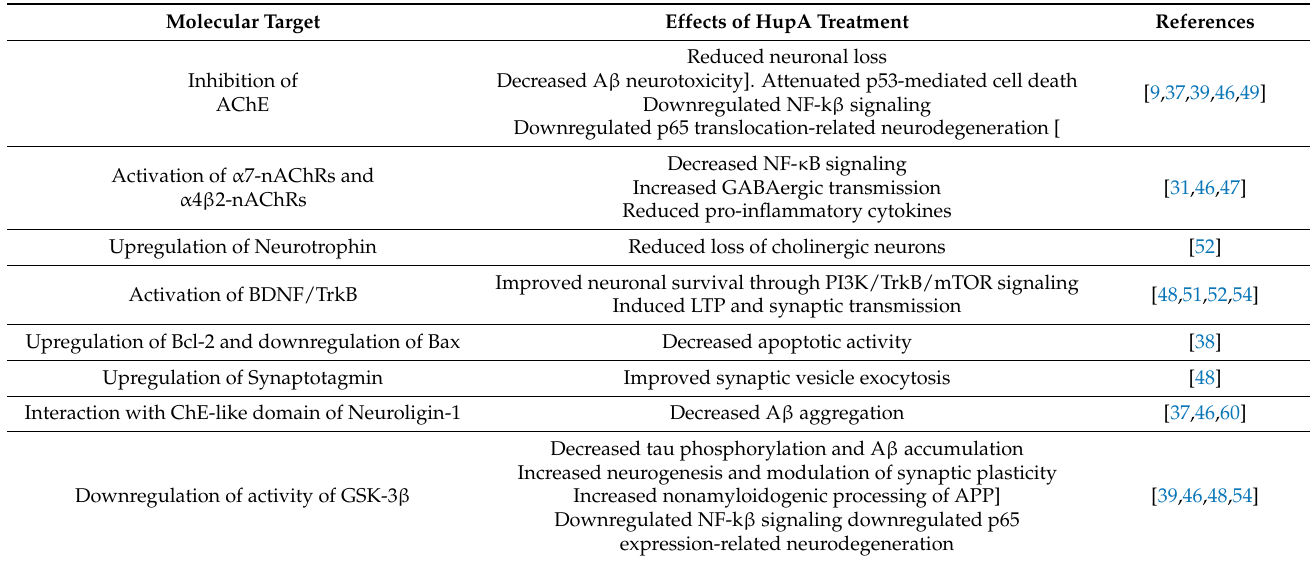
Table 1. Molecular targets of HupA’s cholinergic mechanisms in dementia-related pathologies and effects of treatment.